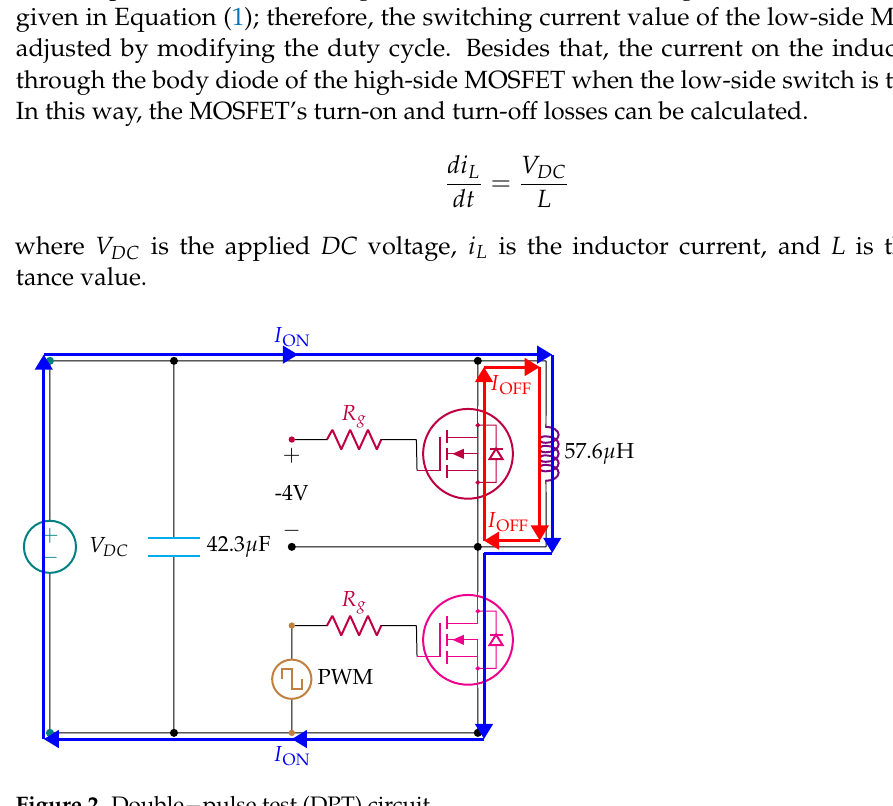
Figure 2. Double Pulse Test (DPT) circuit. Figure 2. Double pulse test (DPT) circuit. − Comparison of switching losses is a valuable indicator to verify the simulation